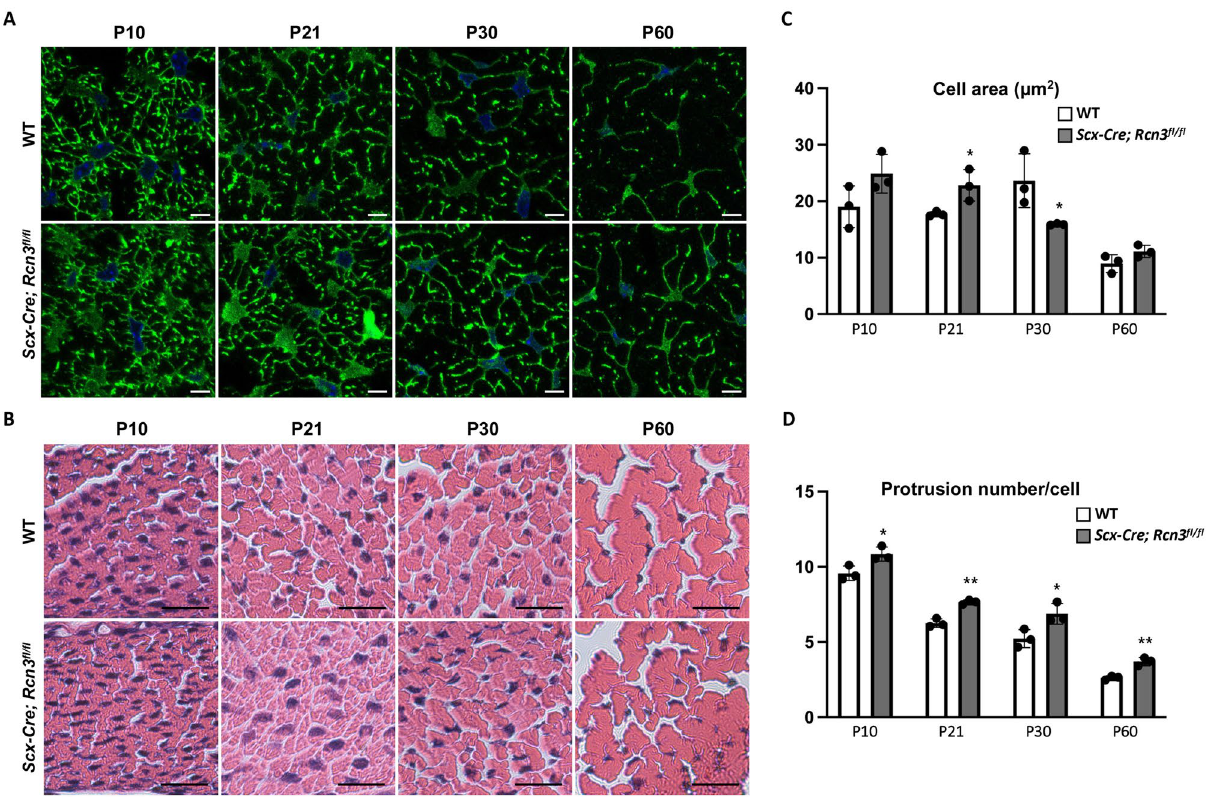
Figure 4. Immunofluorescence staining of ZO1 and phalloidin double staining on cross-sectional patellar tendon from wild-type mice and Scx-Cre; Rcn3 fl/fl (tendon-specific Rcn3 loss-of-function model) littermates during postnatal tendon maturation ( A ). H&E staining of the cross-sectional patellar tendon ( B ). Cell area ( C ) and protrusion number ( D ) of the patellar tendon. (Scale bar indicates 5 µm ( A ) and 20 µm ( B ), * indicates P < 0.05, and ** indicates P < 0.01 between genotypes, n = 3).